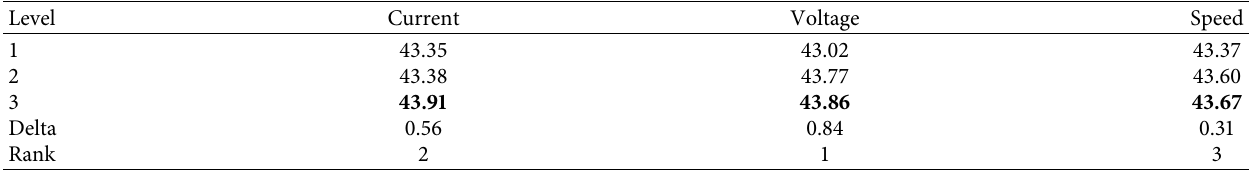
Table 6: Response table for signal-to-noise ratio for hardness of WZ.